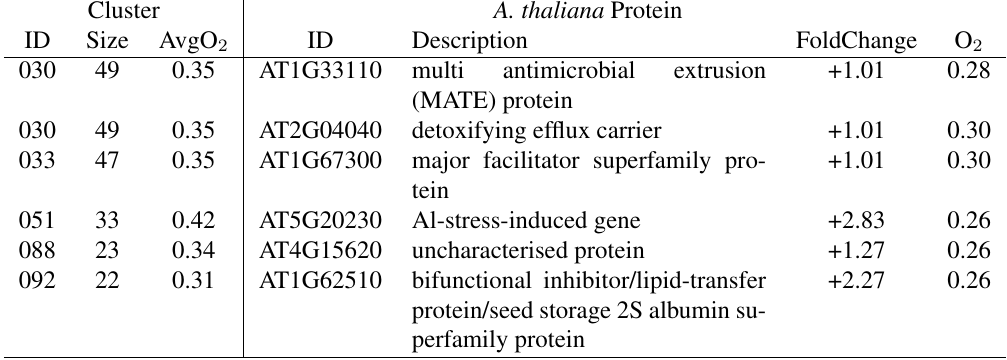
Table 1: Results for A. thaliana . Proteins with significantly up-regulated expression (column Fold- Change) and significant low oxygen content in the amino acid side chains (column O 2 ) under oxygen limited growth. Only results from clusters with more than 10 entries are shown. Proteins with a fold change of +1 are expressed more than twice as strong as in the control. A. thaliana